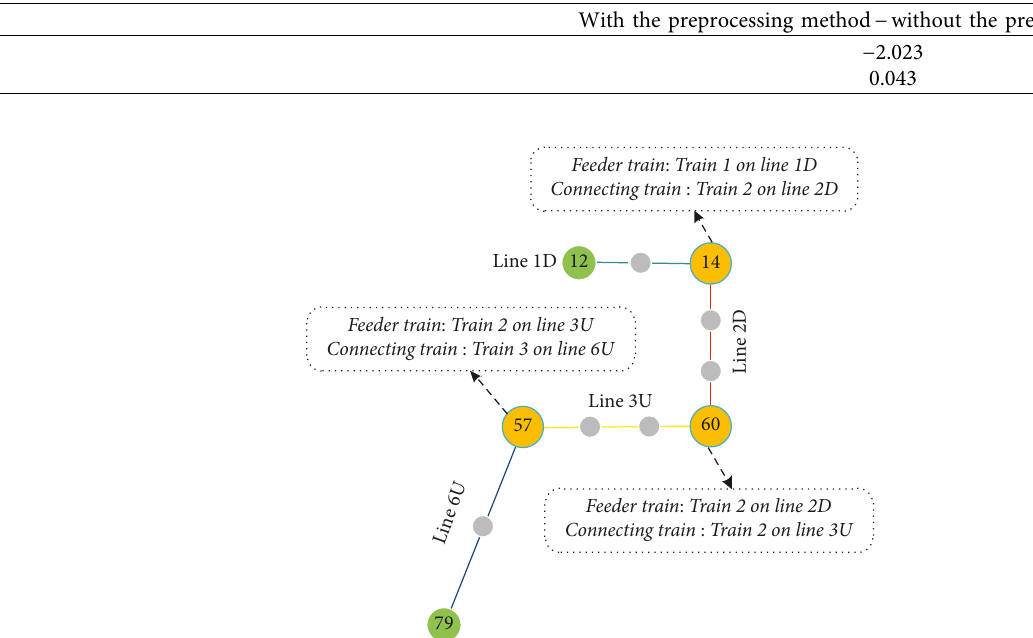
Table 10: Wilcoxon test results.